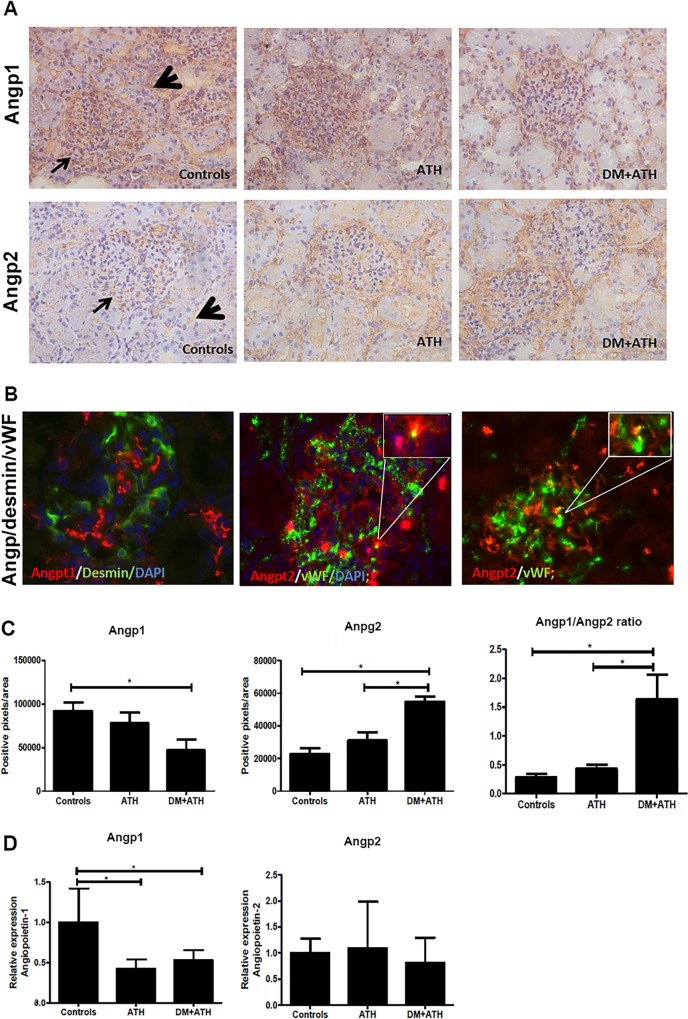
The Angpt2/Angpt1 balance is disturbed in atherogenic DM pigs.A. Representative illustrations of kidney sections stained with Angpt1 (upper panels; arrow: glomerulus; arrowhead: peritubular area) or Angpt2 (lower panels; arrow: glomerulus; arrowhead: tubular staining) in Controls, ATH, and DM+ATH pigs. B. Immunofluorescent double staining of representative kidney sections for desmin (green)/Angpt1 (red;left panel) and vWF (green/Angpt2 (red; middle/right panel). Insets: double positivity for vWF/Angpt2 staining in yellow. C: Quantitative analysis of renal expression of Angpt1, Angpt2 and Angpt2/Angpt1 ratio. D. Relative mRNA expression of Angpt1 and Angpt2. Data are shown as mean ± SEM. *P<0.05 compared to Controls or ATH pigs. Original magnification of A and B: x400.